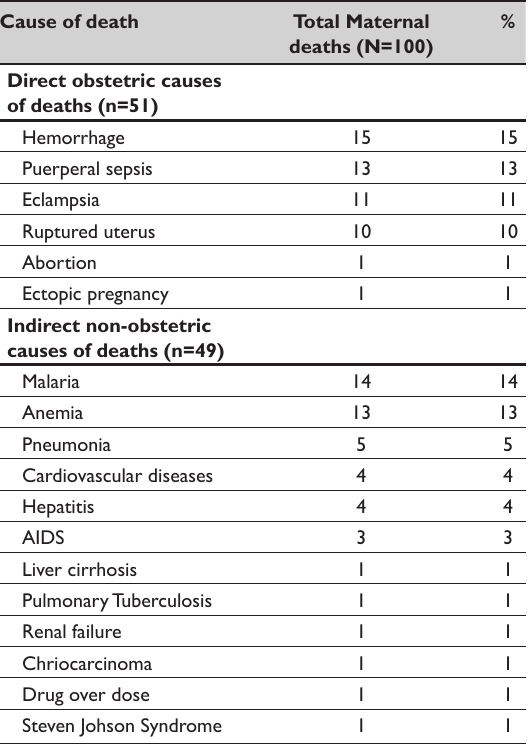
Table 2: Proportion of direct obstetric and indirect non-obstetric causes of deaths, 2010-2014, Kuando Kubango,